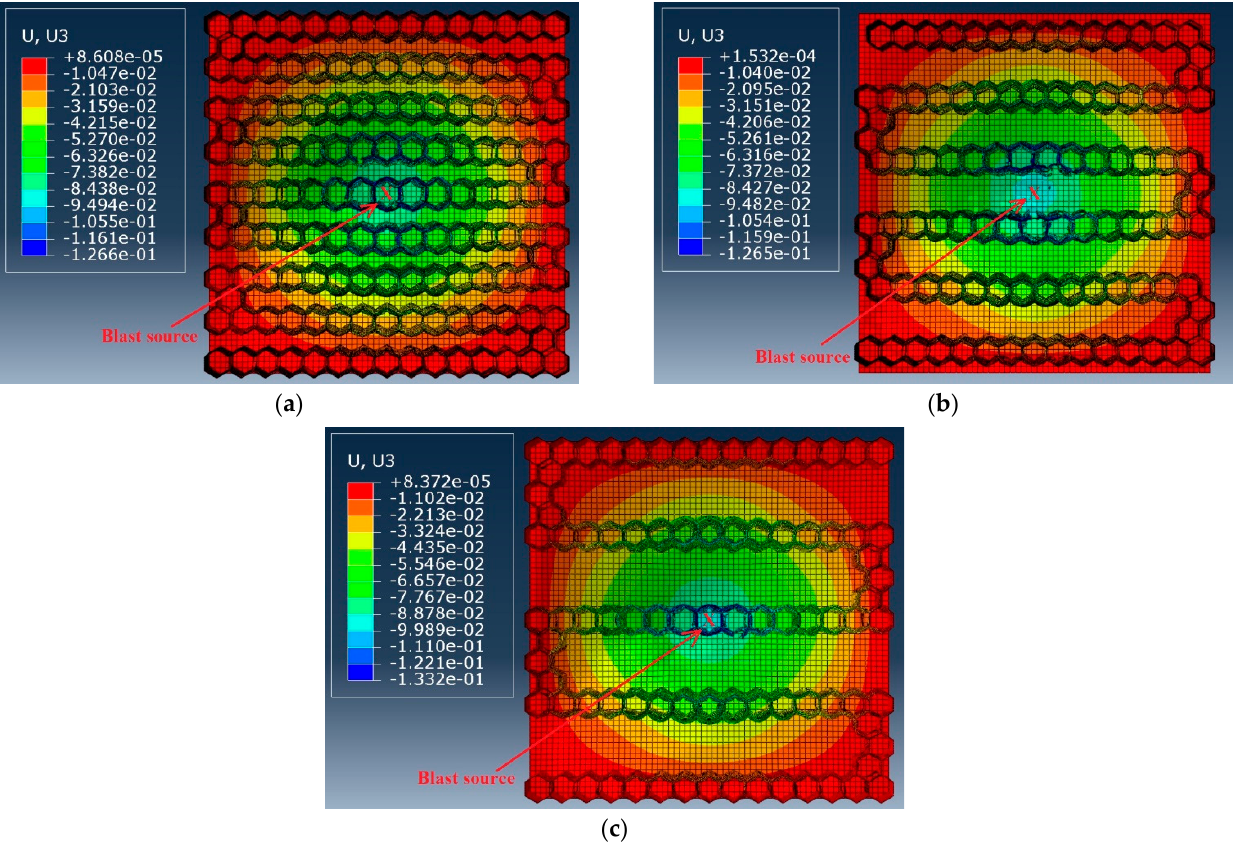
Figure 11. Blast load location for the honeycomb shape—top view ( a ) D = 75 mm ( b ) D = 112.5 mm ( c ) D = 150 mm.